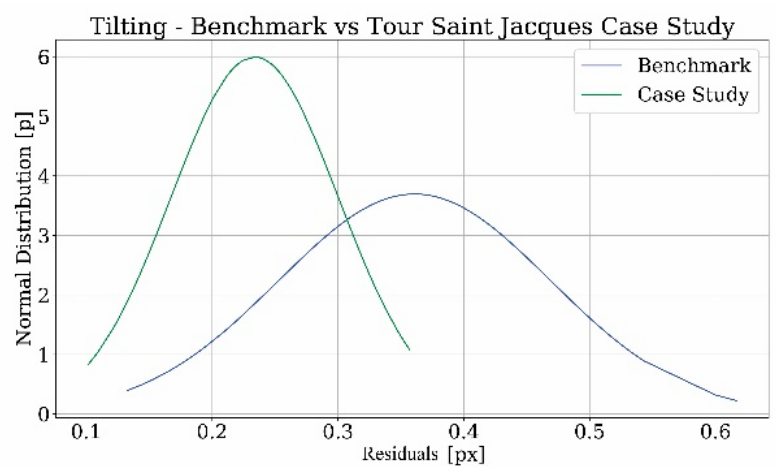
Figure 26. Comparison of normal distribution of the residual value between benchmark and case study considering the tilting camera motion for the Tour Saint Jacques.